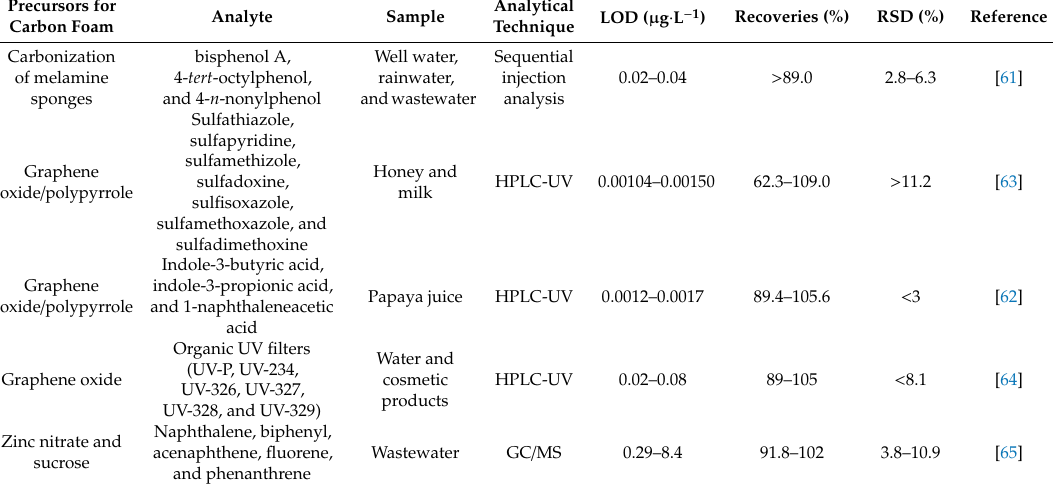
Figure 2. Field-emission (FE)-SEM images of carbon foam. Source: Reproduced from [65], with permission from Elsevier. Table 3. Analytical methods developed based on carbon-based foams. RSD: relative standard